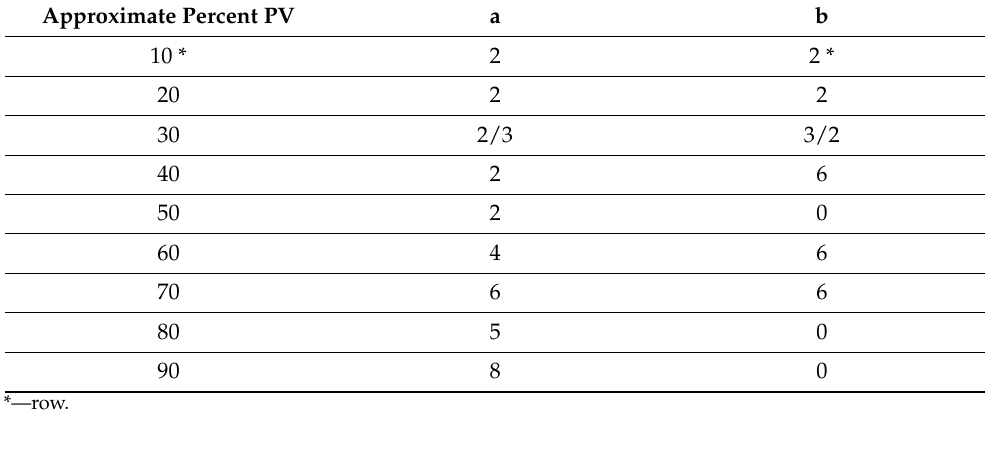
Table 1. Approximate percent of PV coverage per module with factor a and b in darkwhite.scad script [67].